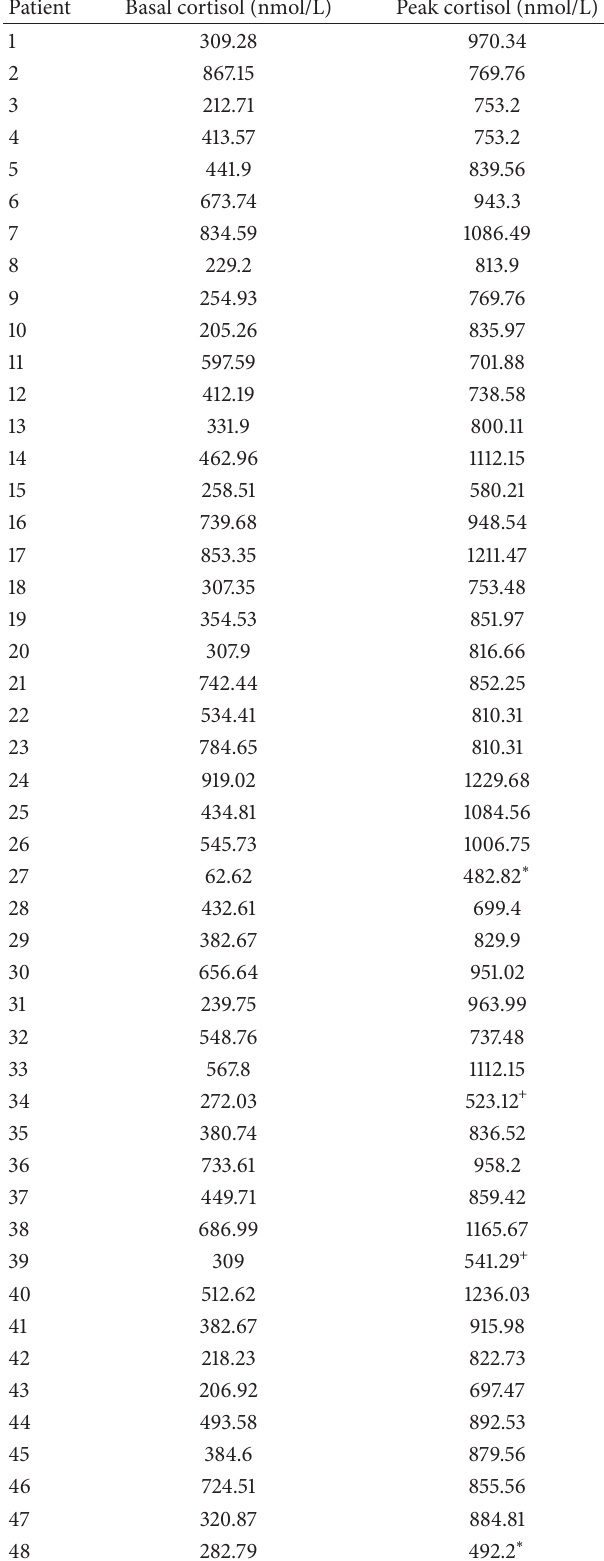
Table 3: Basal and peak cortisol